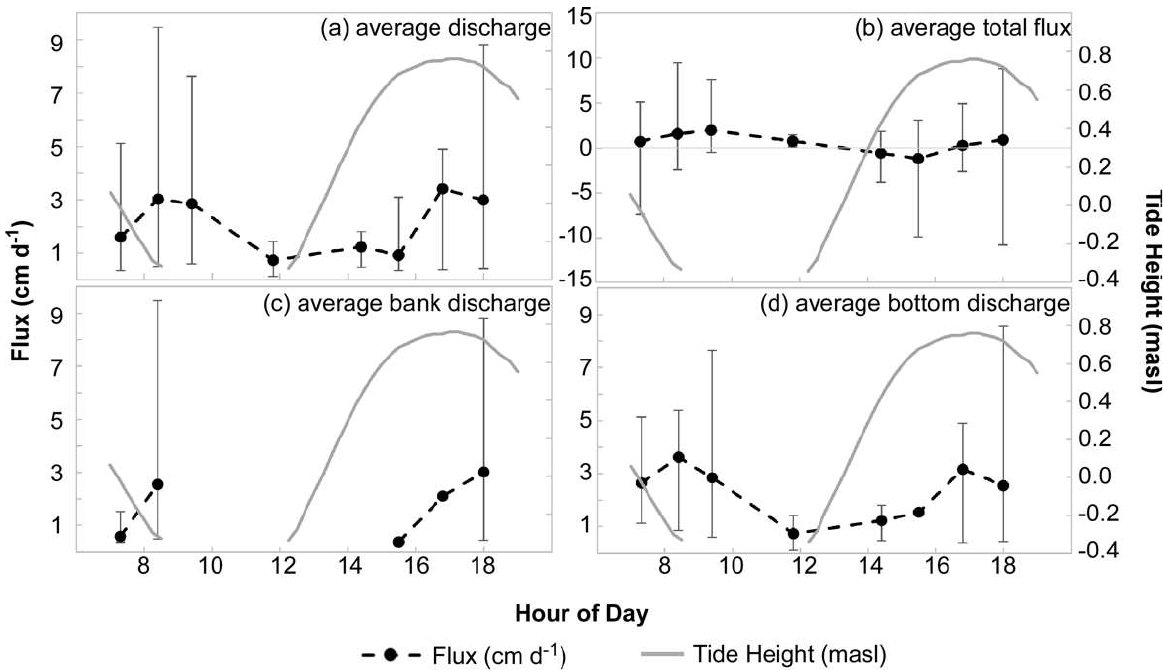
Figure 3. Seepage meter measurements from the St. Jones National Estuarine Research Reserve over one tidal cycle during an August 2016 field campaign. Measurements show ( a ) average ( ± measured range) discharge for all seepage meters (i.e., bank and bottom; n = 16); ( b ) average net exchange for all seepage meters (discharge + recharge); ( c ) average discharge from seepage meters in the creek bank; and ( d ) average discharge from seepage meters in the creek bottom. Note the gaps in ( c ) reflect time periods in which the seepage meters were exposed, and gaps in tide height indicate that the logger was out of water. Water level data from the Delaware Department of Natural Resources and Control.